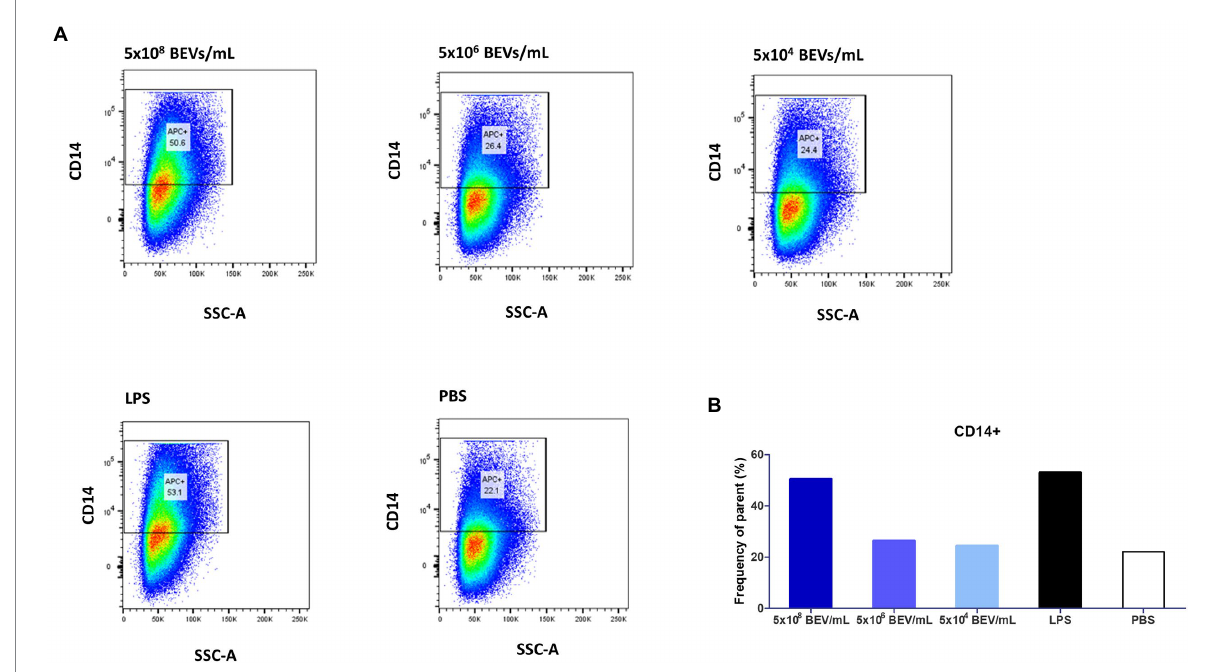
FIGURE 4 Bt BEVs elicit phenotypic changes in THP1-Blue NF- κ B cells (10 6 cells/ml). (A) THP-1 cells were incubated with different concentrations of Bt BEVs for 24 h and analyzed for CD14 expression by flow cytometry. Gating strategy was based on scatterplots of CD14 vs. side scatter signal. (B) The bar graph represents THP-1 cells with high expression of CD14 as percentage frequency of